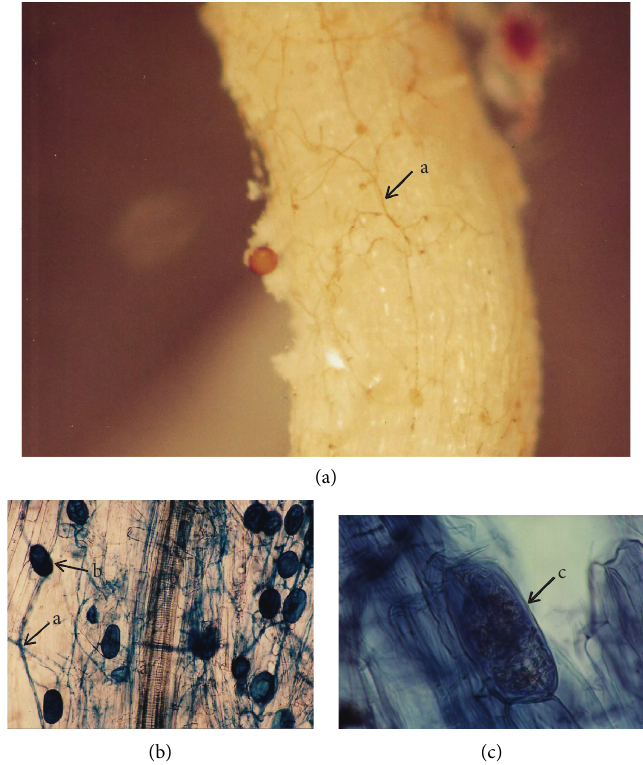
Figure 9: Effects of AMF inoculation on the root colonization of L. leucocephala seedlings at different NaCl stress. AMF: arbuscular mycorrhizal fungi. ∗ : significant at 0.01 ≤ P ≤ 0 . 05; ∗∗ : significant at P ≤ 0 . 01. Bars that do not share a letter are significantly different at P ≤ 0 .